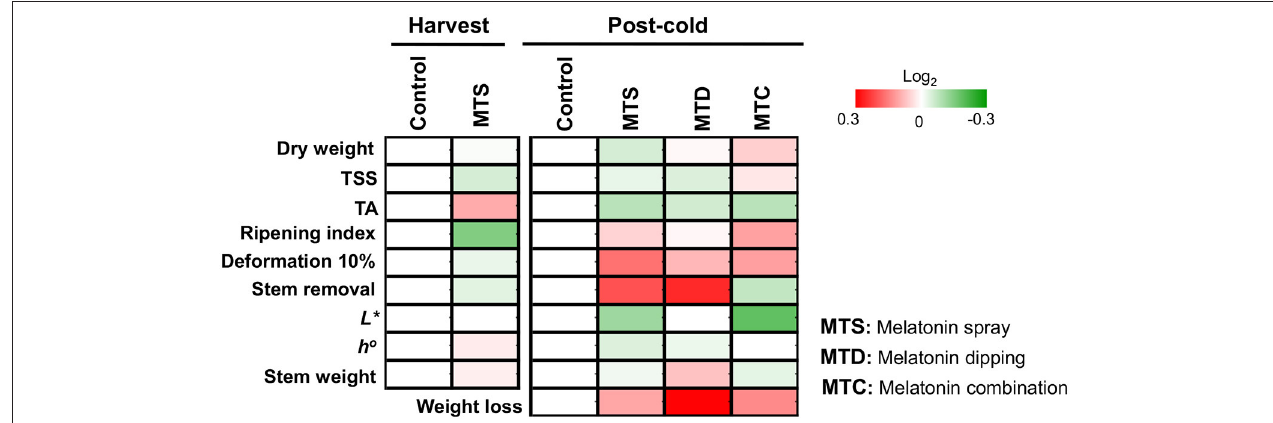
FIGURE 1 | The impact of melatonin pre-harvest foliar spraying and post-harvest fruit dipping, in combination or alone (MTD, melatonin dipping; MTS, melatonin spray; MTC, melatonin combination) in sweet cherry ripening features pictured as heat map profiles. After melatonin pre- and post-harvest application, fruits were cold stored (0 ◦ C, RH 90%) for 14 days and subsequently were transferred at ambient temperature (20 ◦ C) for 8h. Fruits were sampled either at the harvest stage (harvest) or following cold storage (post-cold). For each ripening trait, the ratio between treatments to control transformed into log 2 and depicted with color scale (green indicate relative decrease, red indicate relative increase, and white indicate no fold change). Relative values for each ripening parameter are provided in Supplementary Table 1 .